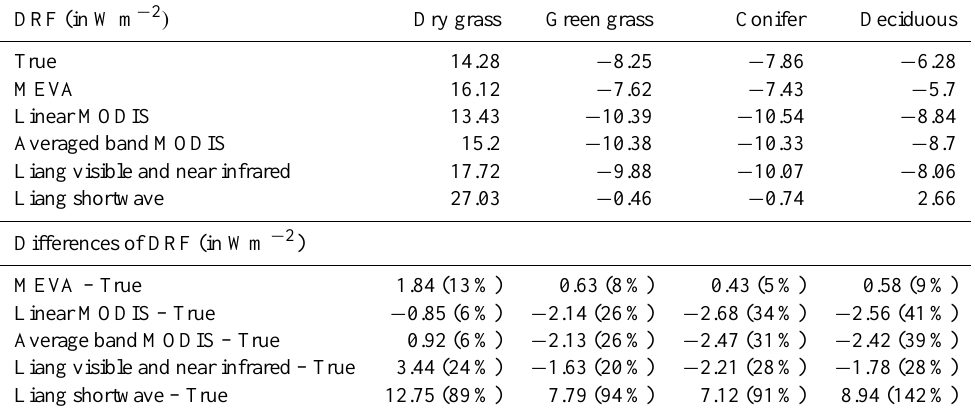
Table 2. The calculated instantaneous aerosol direct radiative forcing (DRF, in Wm − 2 ; from 0.3 to 2.5µm) in clear-sky condition over dry grass, green grass, conifer, and deciduous surfaces. Other parameters used include AOD (at 0.55µm) of 0.32, SSA (at 0.55µm) of 0.89, and SZA of 30 degrees. Bold numbers represent the difference in aerosol forcing associated with different approaches to estimate surface reflectance spectrum. The numbers in parentheses indicate the ratio of the absolute difference to the aerosol forcing calculated with